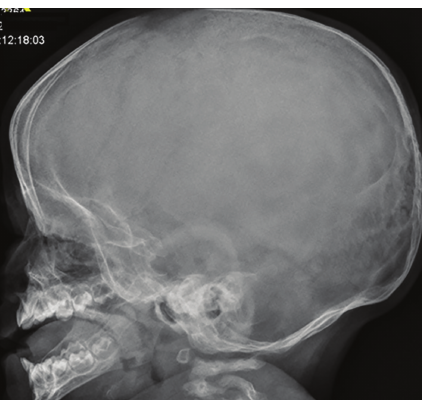
Figure 1: Lateral skull radiograph showed low mineralization of the skull bones associated with persistent opening of the anterior fontanelle. The brain convolutions were apparent because of the demineralized calvaria. Note the bulging frontal area. No evidence of wormian bones and/or dentinogenesis imperfecta.